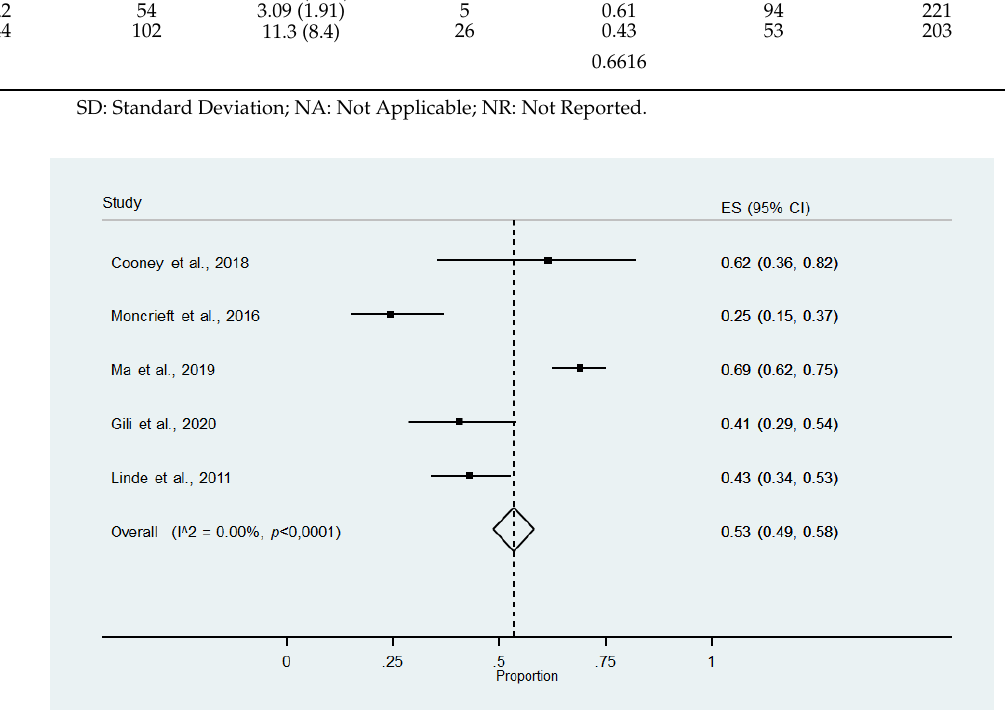
Table 2. Adherence outcome data (completers and mean proportion of session completed) and dropout data. Reference